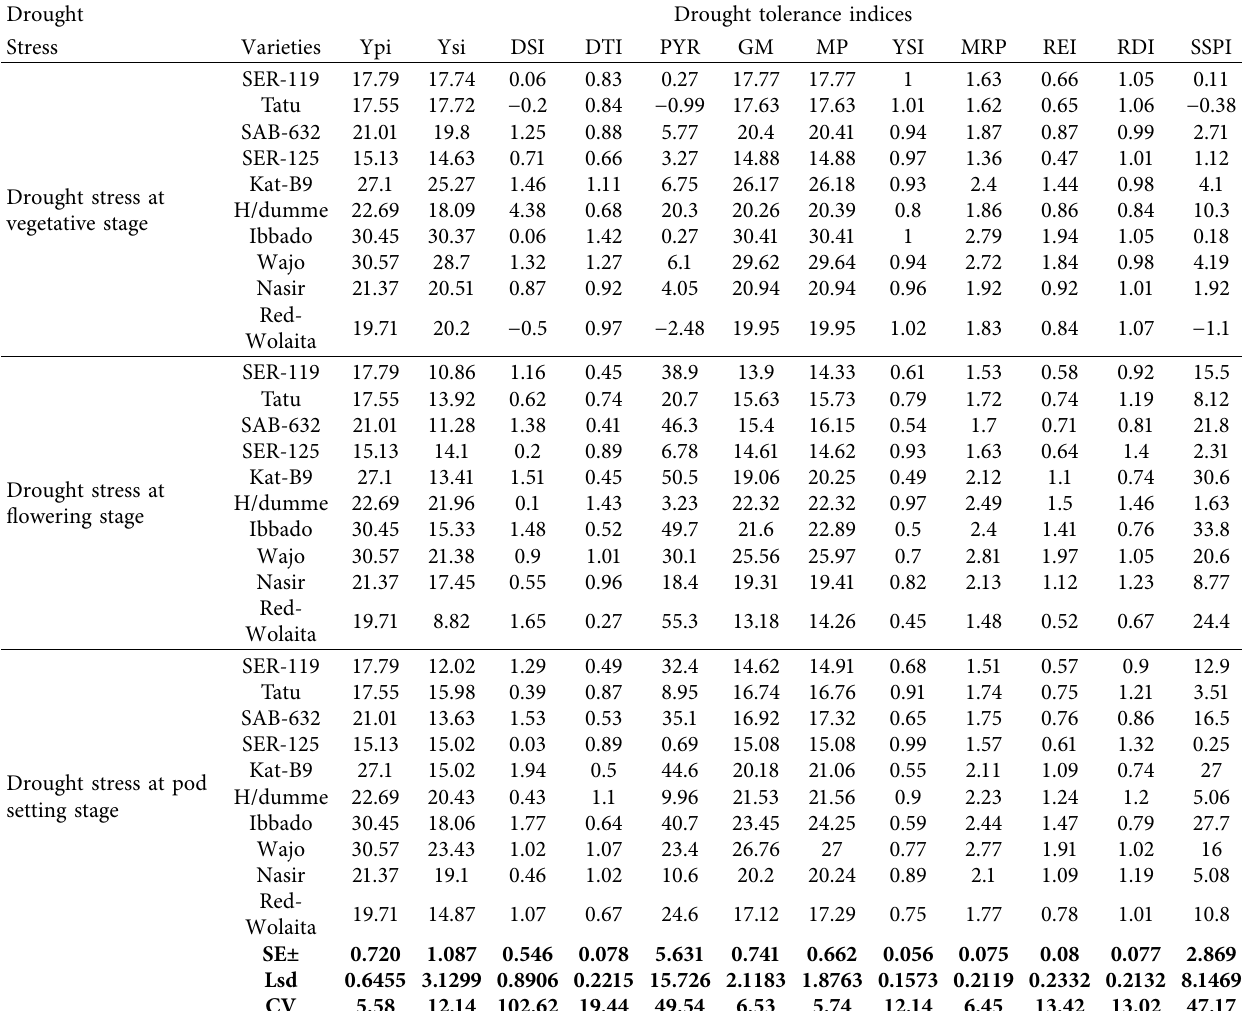
Table 3: Seed yield (g plant − 1 ) under nonstress and drought stress and drought tolerance indices of haricot bean varieties exposed to drought stress at different growth stages. Drought